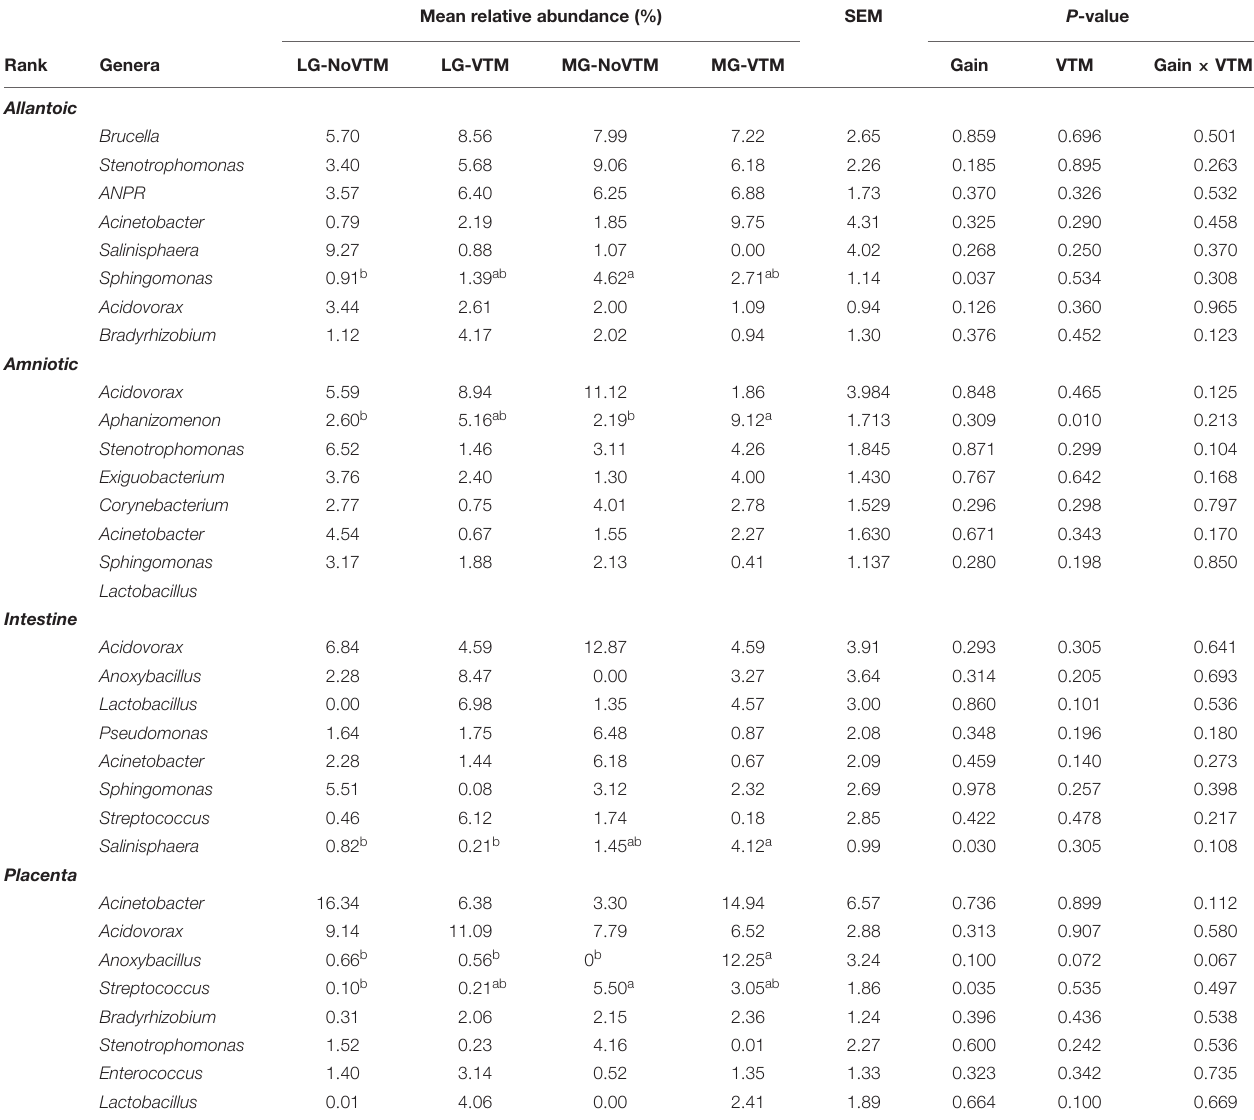
TABLE 1 | The effects of rate of gain, and vitamin and mineral supplementation on the relative abundance of the eight most relatively abundant genera present in allantoic and amniotic fluid, and intestine and placental microbiota in 83-day-old calf fetuses. Mean relative abundance (%) SEM P